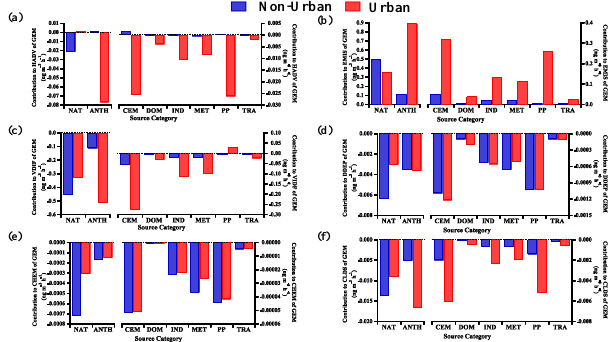
Figure 8. Impact of emission sources on (a) HADV, (b) EMIS, (c) VDIF, (d) DDEP, (e) CHEM and (f) CLDS processes of GEM.